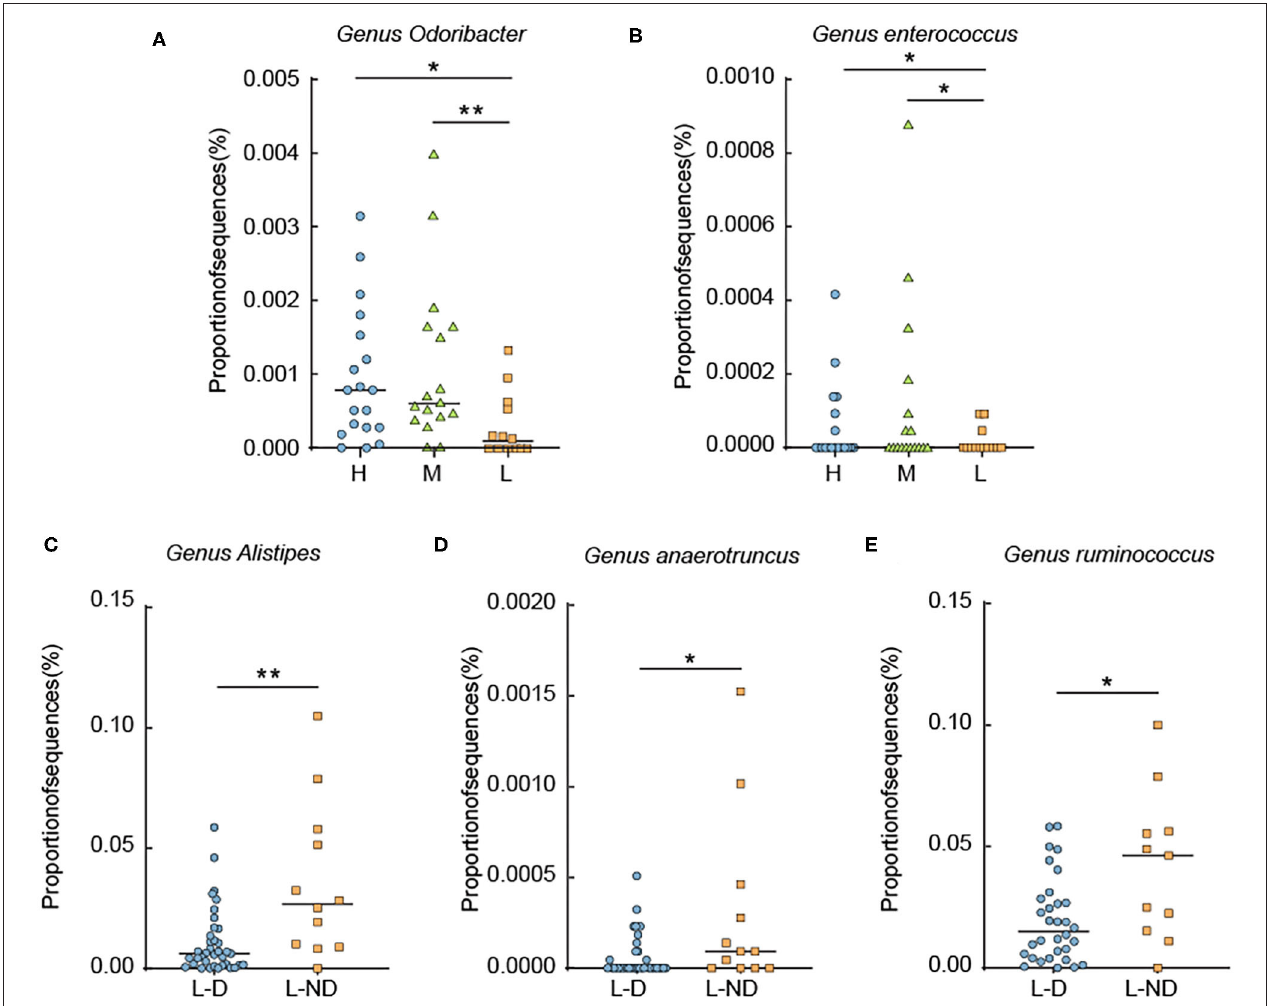
FIGURE 5 | Relative abundance analysis of some metabolic representative species. (A,B) Relative abundance of the genera Odoribacter and Enterococcus among groups divided by L-thyroxine dosage. (C–E) Relative abundance of the genera Alistipes , Anaerotruncus , and Ruminococcus divided by L-thyroxine dosage development within the LRT group. Error bars are calculated as a standard error (SEM). The differences among groups were compared using nonparametric tests. * p < 0.05, ** p < 0.01, defined statistically